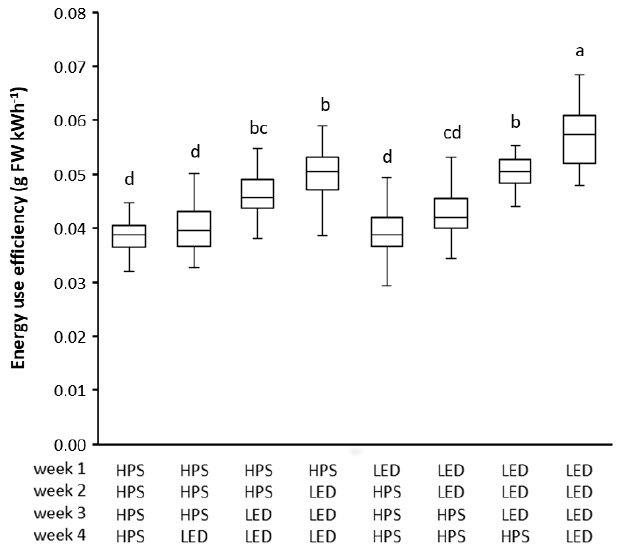
Fig. 3. Energy use efficiency of red winter lettuce ‘Carmoli‘ after four weeks growth period under different light treatments. Lettuce plants received either the whole growth period HPS or LED light, or different number of weeks HPS and LED light. Plant measurements represent individual measurements of 40 plants for each light treatment (four repetitions consisting of ten individual plants each). Differences between light treatments are based on pairwise t test and different letters indicate significant differences between means at the p =